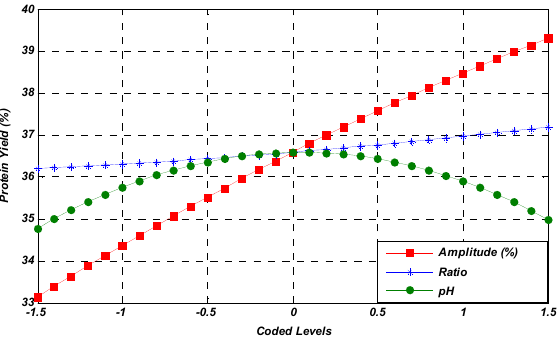
Figure 1. Linear effect of studied parameters on the MOSP yield.